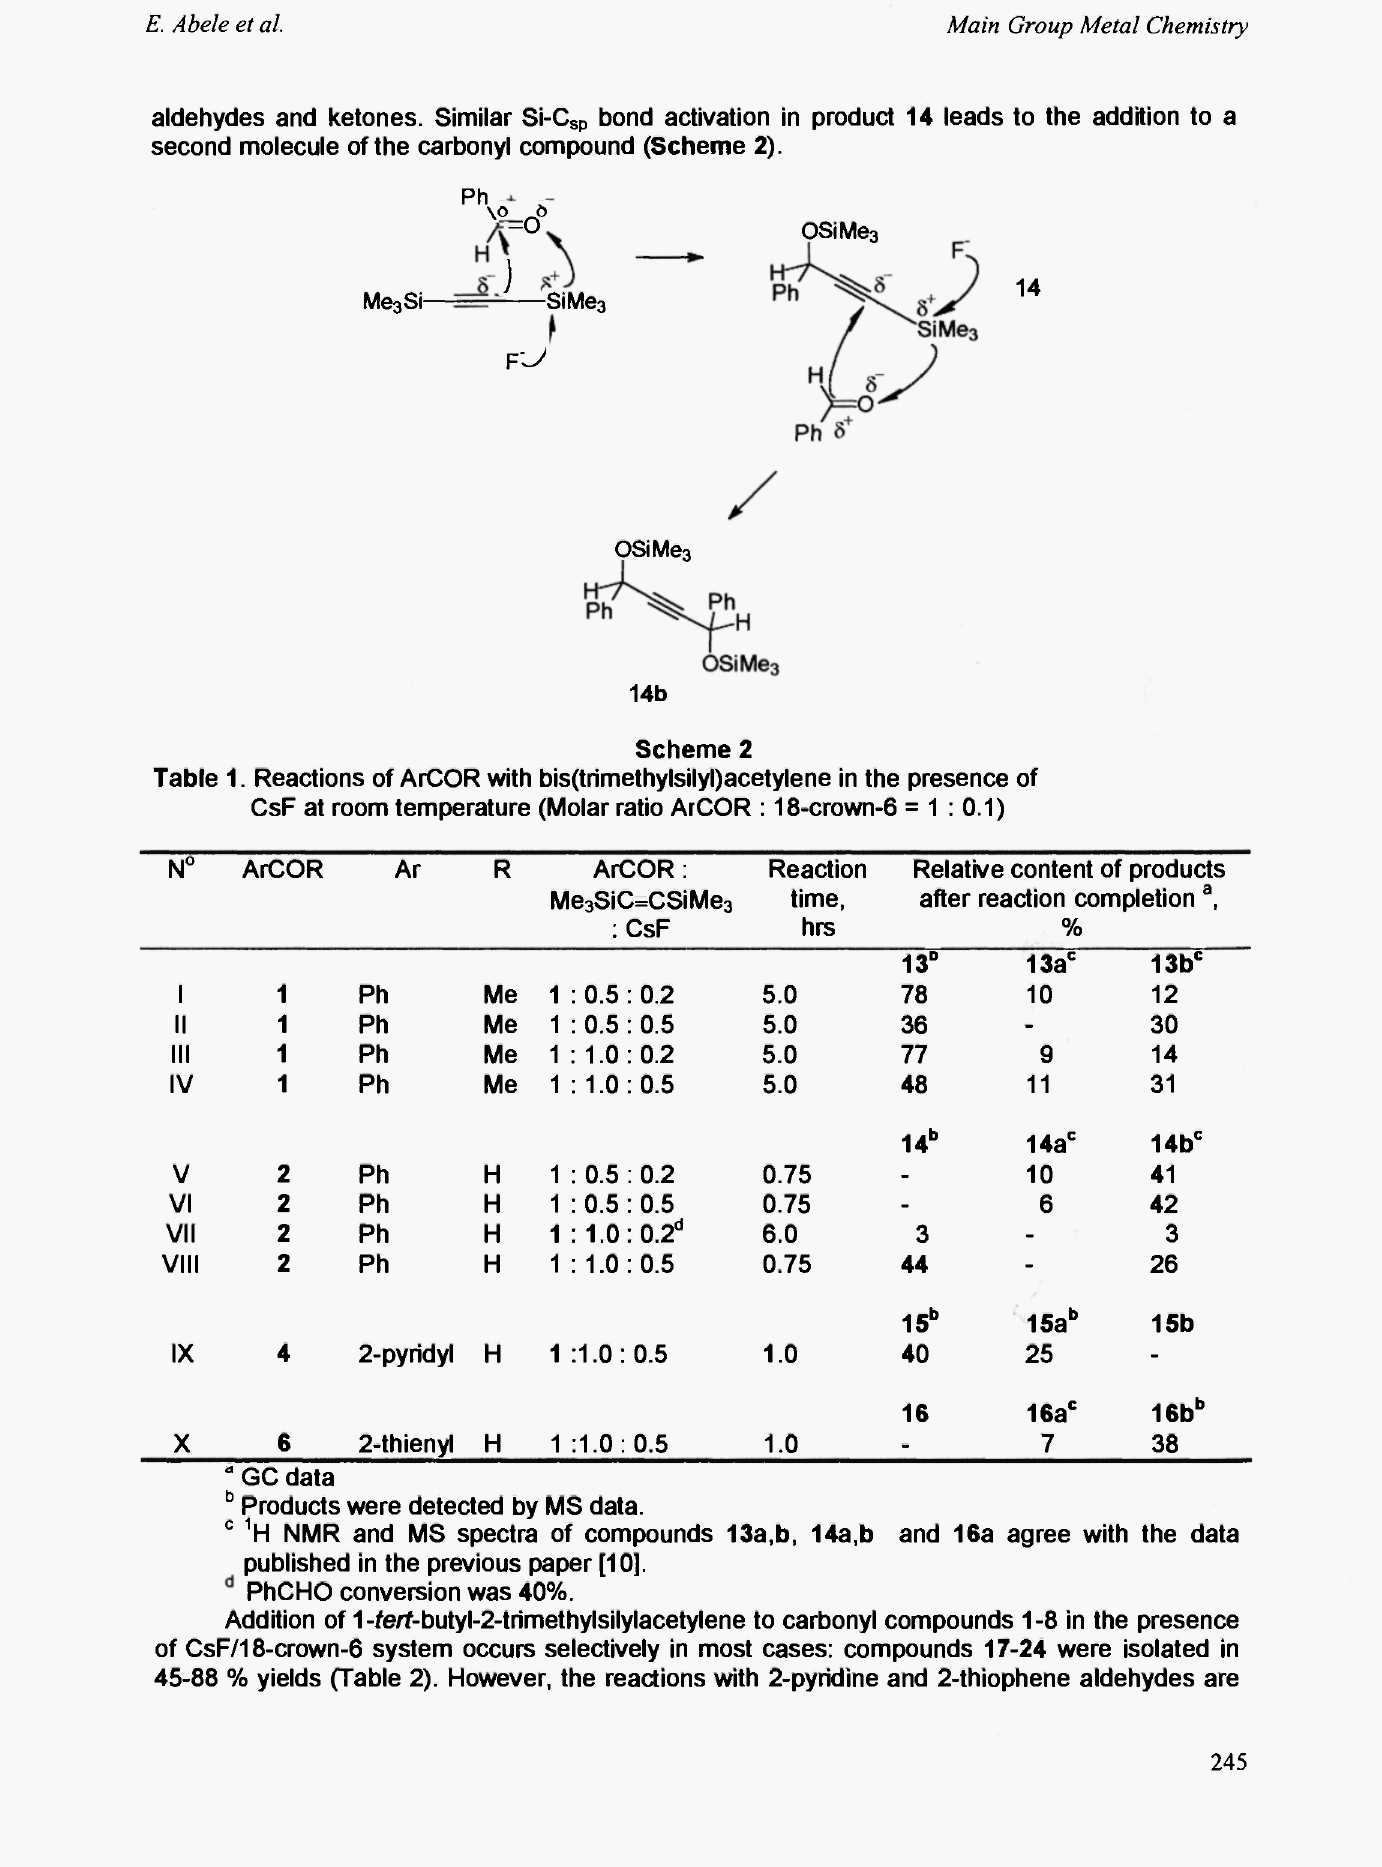
Table 1. Reactions of ArCOR with bis(trimethylsilyl)acetylene in the presence of CsF at room temperature (Molar ratio ArCOR : 18-crown-6 = 1 : 0.1)